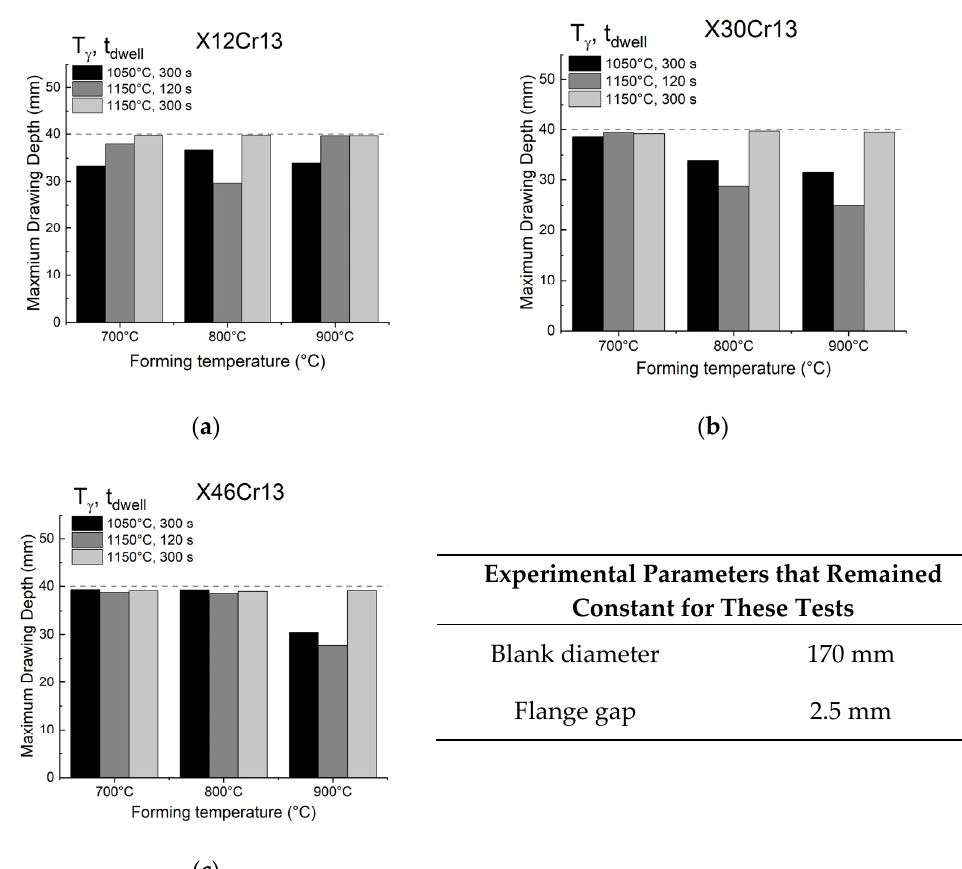
Figure 8. Maximum drawing depth as a function of the austenization temperature and initial forming temperature for the X12Cr13 ( a ), X30Cr13 ( b ), and X46Cr13 ( c ) alloys.